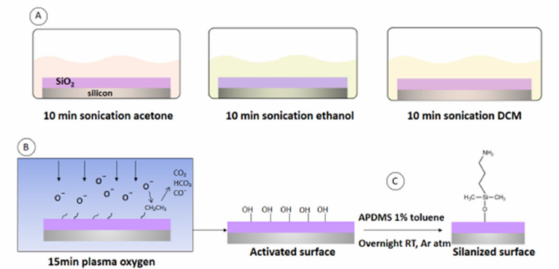
Figure 1. ( A ) Monolayer formation steps. Washing for 10 min in acetone, 10 min in ethanol, and 10 min in DCM. ( B ) 15 min plasma surface activation (creation of OH groups). ( C ) Silane (APDMS) reaction to -OH groups generating a silanized